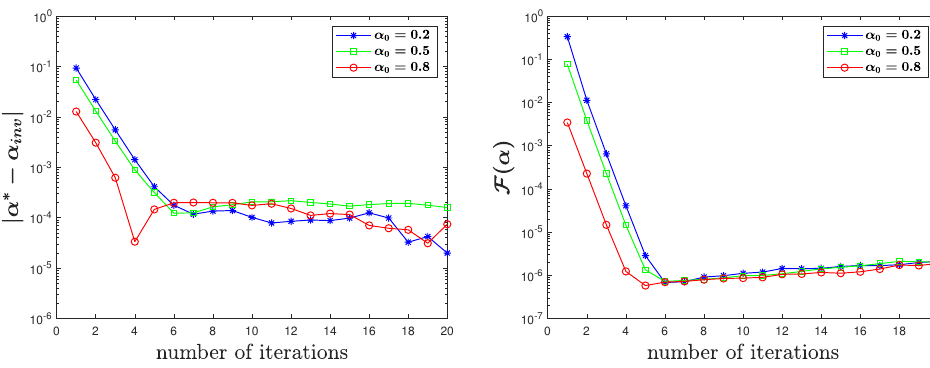
Figure 5. α ∗ = 0.75 for contaminated observation data with 0.01% of noise in Test 2.